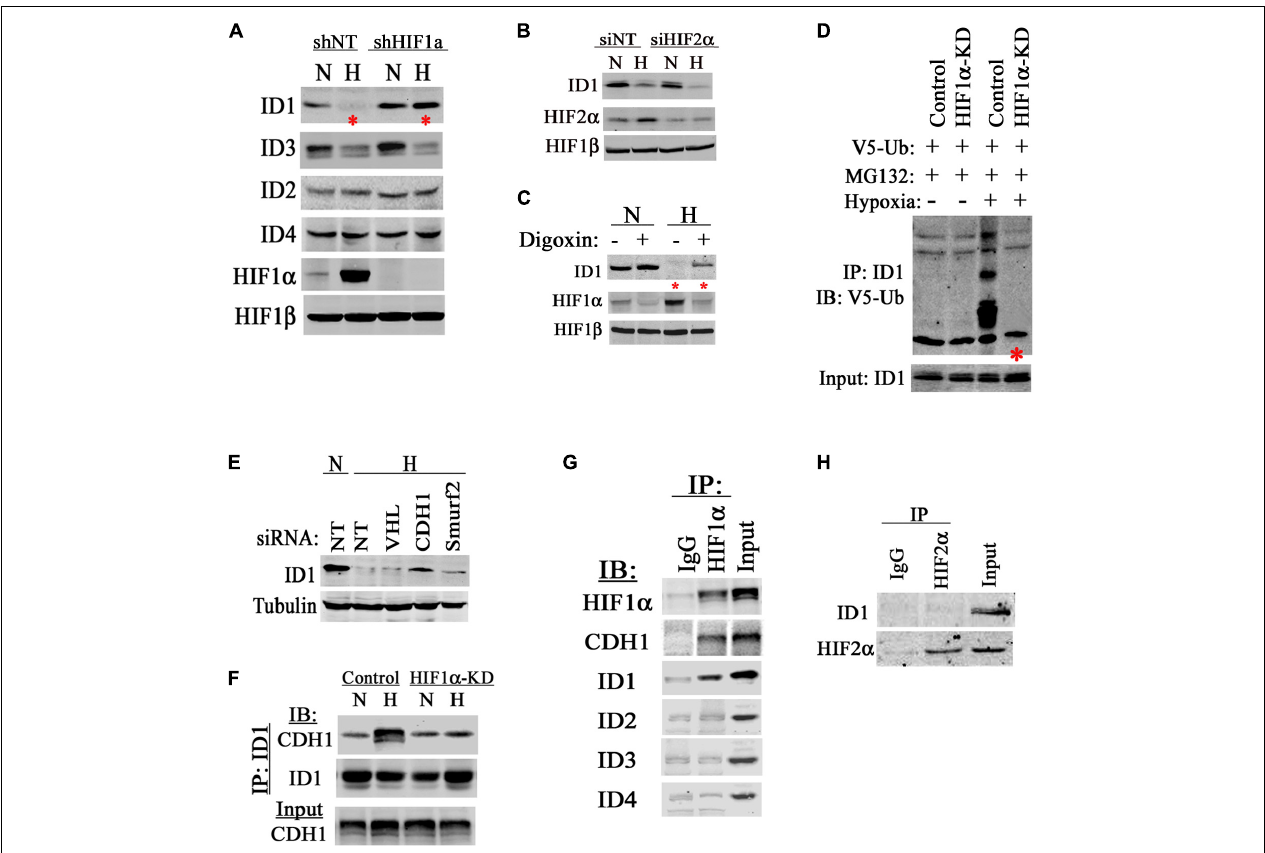
FIGURE 2 | HIF1 α accelerates ID1 protein degradations. (A) Western blots of ID1-ID4, HIF1 α , and HIF1 β in PC3 cells isogenic for HIF1 α (shNT/shHIF1 α ) in 20% (N) or 1% (H) O 2 . (B) Western blots of ID1, HIF2 α , and HIF1 β in PC3 cells with siRNA silencing HIF2 α in 20% (N) or 1% (H) O 2 . (C) Western blots of ID1, HIF1 α , and HIF1 β in PC3 cells being treated with HIF inhibitor Digoxin (Sigma) in 20% or 1% O 2 . (D) Hep3B cells with stable shRNA knockdown (KD) of HIF1 α or non-targeting control (Control) were transfected with plasmid coding for V5-tagged ubiquitin. Cells were then treated with MG132 in 20% or 1% O 2 , ID1 protein was immunoprecipitated (IP) and immunoblotted (IB) for V5-ubiquitin modification. (E) Hep3B cells were treated with siRNA against VHL, APC/CDH1 (CDH1), or Smurf2 for 48 h. Afterward, cells were cultured in 20% (N) or 1% (H) O 2 for 6 h and ID1 levels were measured by western blots. (F) Hep3B Control and HIF1 α -KD cells were cultured in normoxia or hypoxia overnight, and ID1 was IP and IB for the association with APC/CDH1. (G) PC3 cells were cultured in hypoxia with MG132 for 6 h. HIF1 α was then IP and IB for associations with APC/CDH1 and ID1-ID4. (H) PC3 cells were cultured in hypoxia with MG132 for 6 h, HIF2 α was then IP and IB for the association with